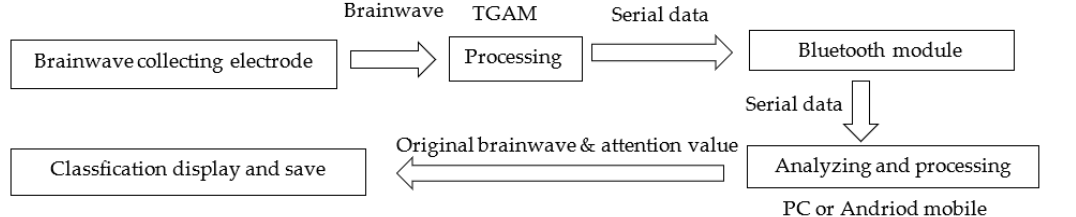
Figure 1. Data acquisition process of MindWave EEG headset.